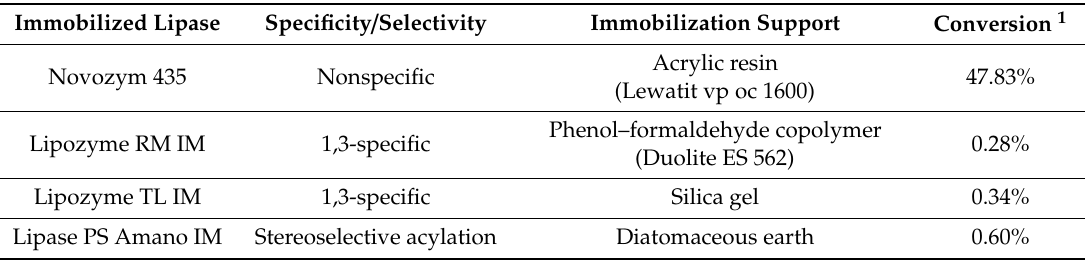
Table 2. Properties of commercial immobilized lipases and values for the conversion 1 of formic acid to phenethyl